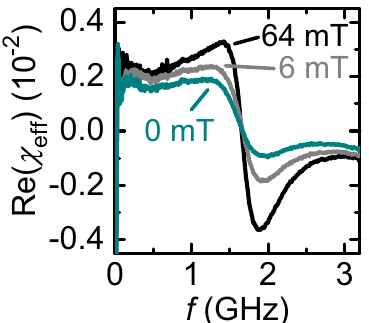
Figure 4. Dynamic susceptibility of modes with different polarization and similar eigenfrequency. Real part of the effective dynamic susceptibility in the helical (0 mT), conical (6 mT), and field-polarised (64 mT) phase at 57.3 K. Each magnetic phase provides a different polarization of the magnetization dynamics [see Fig. 3(b)]. The signal strength, i.e., peak-to-peak variation of the effective susceptibility, amounts to about 0.007 (0.003) in the field-polarized (helical)